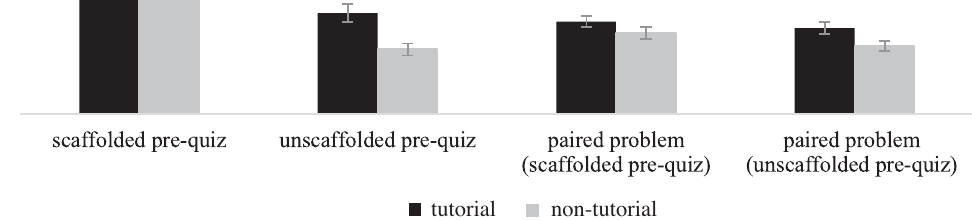
FIG. 4. Average performance on the prequiz problems and paired quiz problems and standard error bars for the students who worked through the tutorials and those who did not.